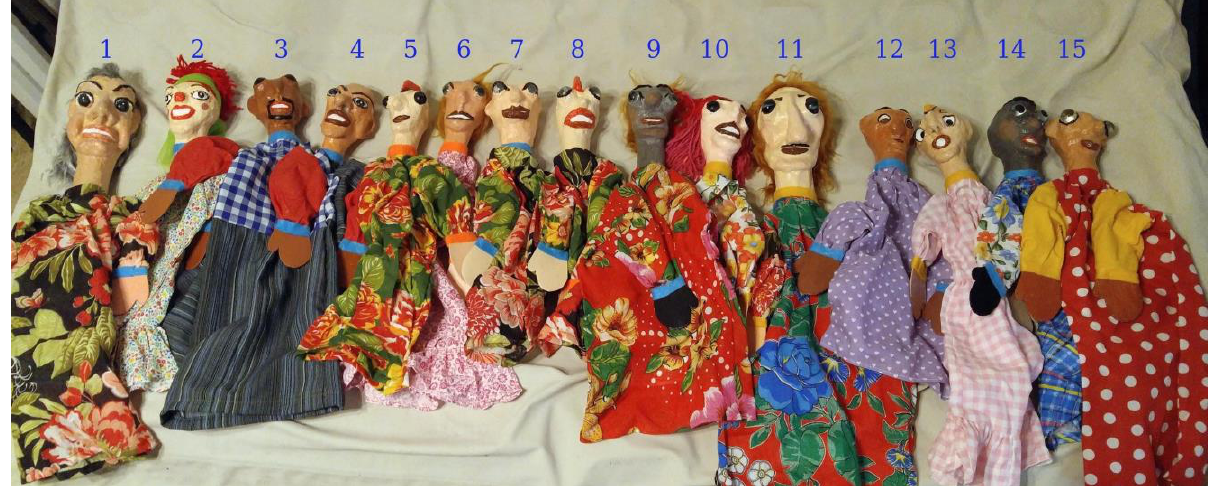
Figure 15. Photo by Joseph Deken of Maria Oliveira’s paper-mache mamulengos numbered to be sent for Pure Data contributors around the